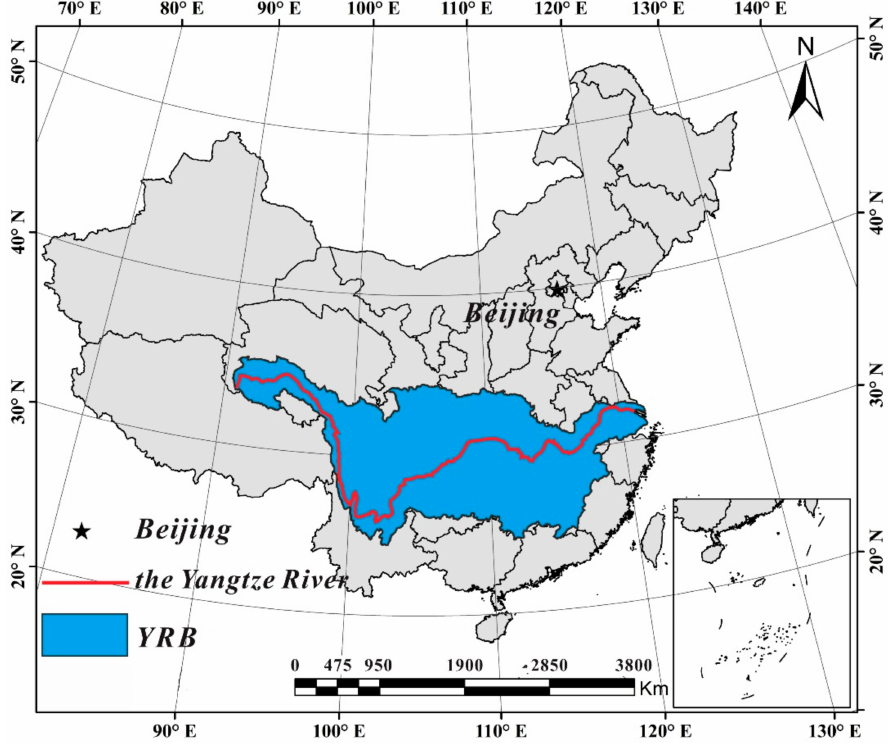
Figure 1. The study area of Yangtze River Basin (YRB) in